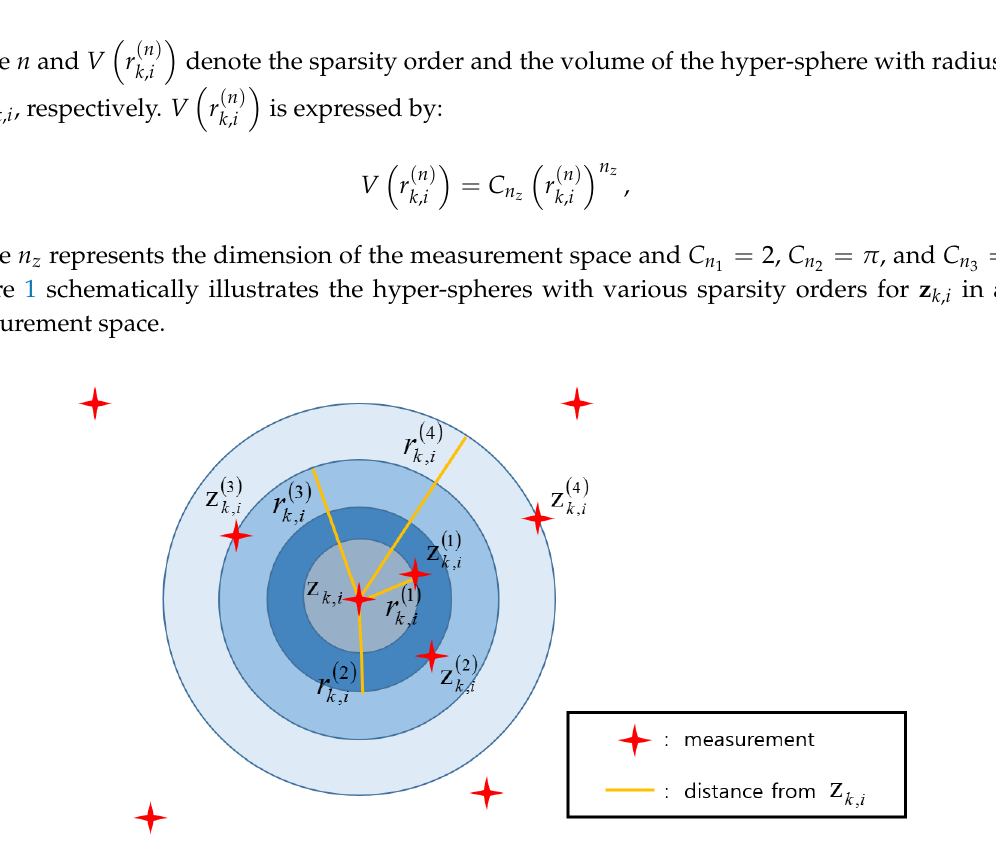
Figure 1. Hyper-spheres for the existing spatial clutter measurement density estimator (SCMDE) in a 2D